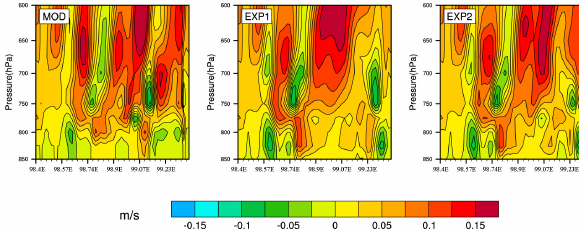
Fig. 12. Vertical latitudinal section of vertical velocity (ms − 1 ) from the MOD, EXP1 and EXP2 simulations at 13:00BT, 6 July